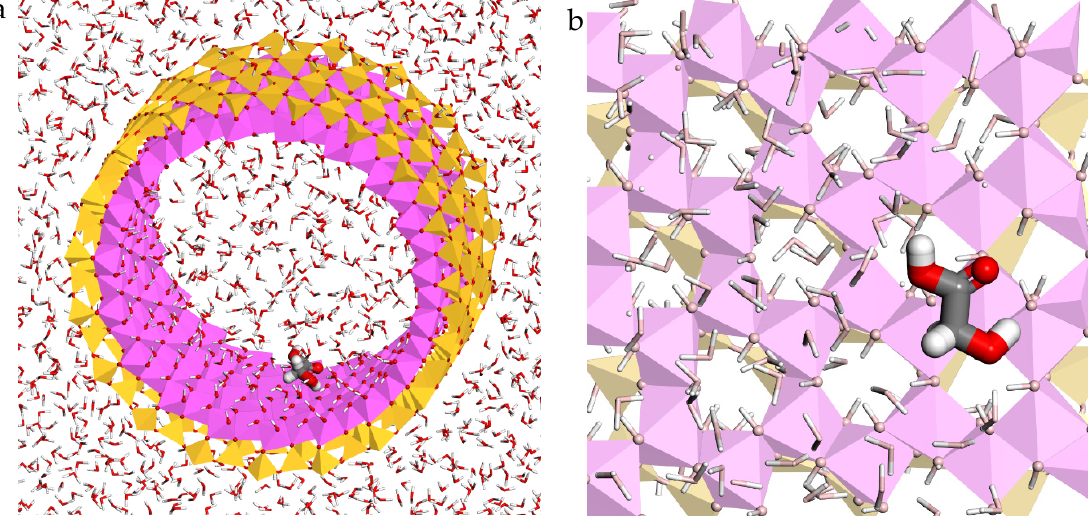
Figure 4. Optimized adsorption complex of the glycolic acid adsorbed on the nanotube inner surface in an aqueous envi- ronment, views from (001) ( a ) and (100) ( b ) planes. The Si, Al, H, C, O, and N atoms are represented in yellow, pink, white, grey, red, and blue colours, respectively.